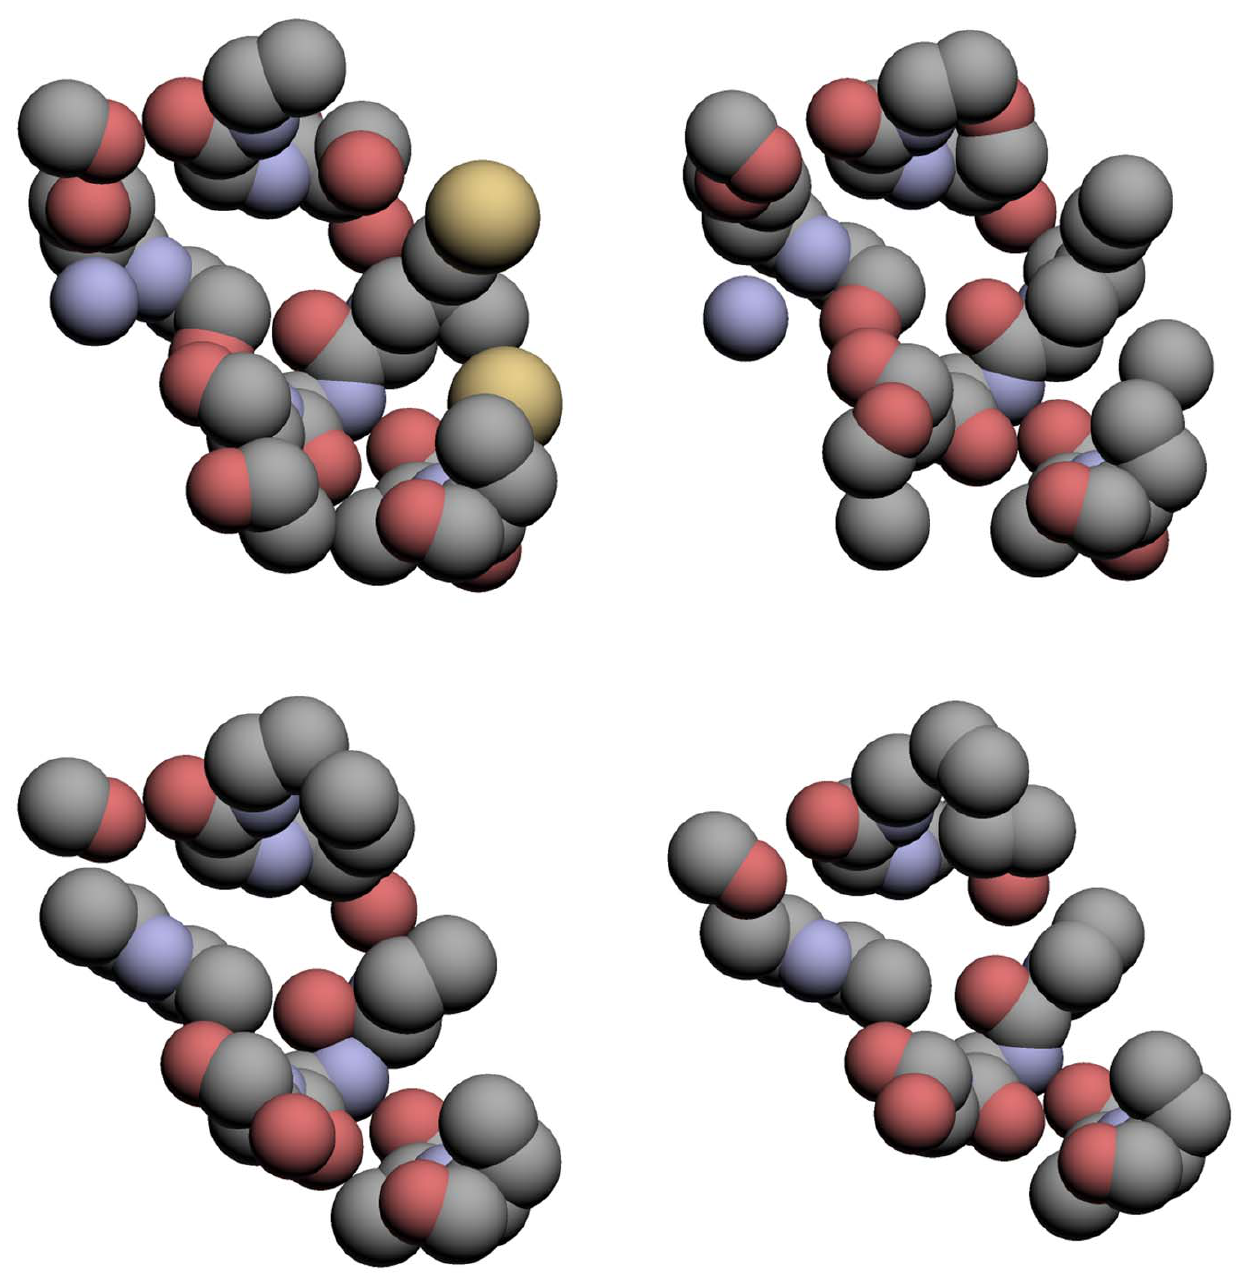
Figure 2. The atoms common to the ATP binding site of 1ct9 and the APC binding site of 1q19 as found using TIPSA (top) and SitesBase (bottom).